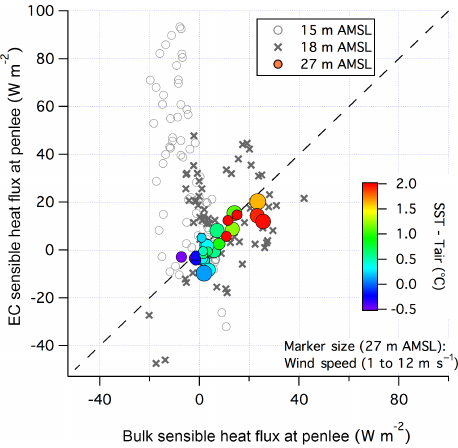
Figure 5. EC sensible heat flux vs. bulk sensible heat flux computed using SST from the L4 station. For June–July 2014 (27ma.m.s.l.), the colour-coding indicates the sea-air temperature difference, while the marker size corresponds to wind speed (1–12ms − 1 ) .